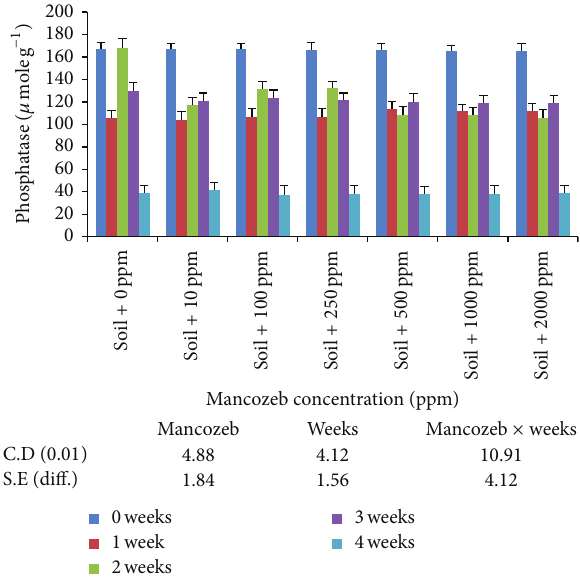
Figure 10: Effect of mancozeb on phosphatase in